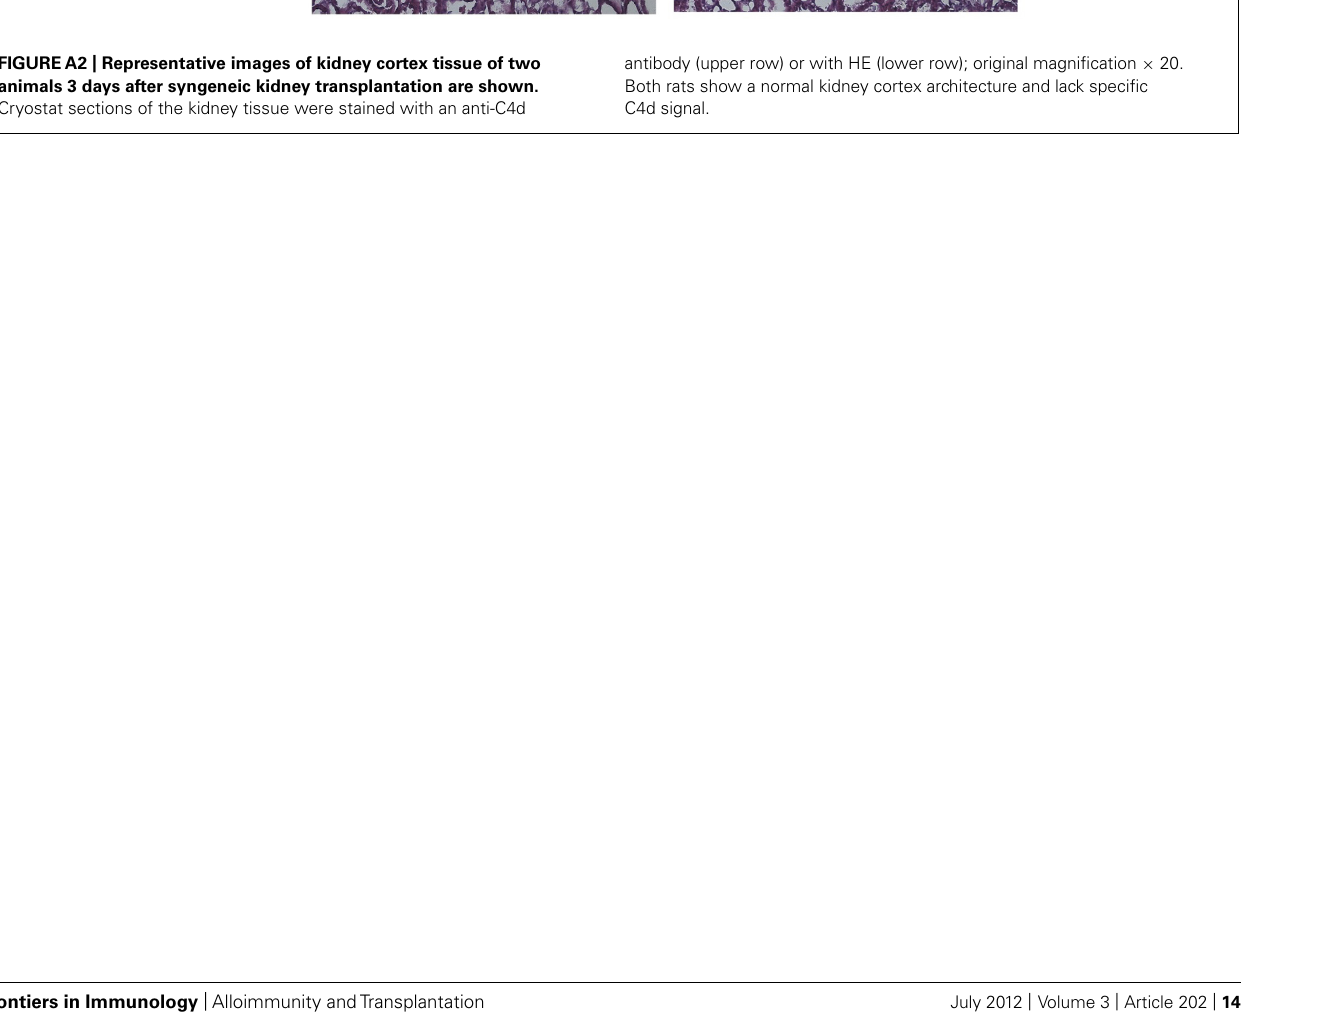
FIGUREA2 | Representative images of kidney cortex tissue of two animals 3 days after syngeneic kidney transplantation are shown. Cryostat sections of the kidney tissue were stained with an anti-C4d